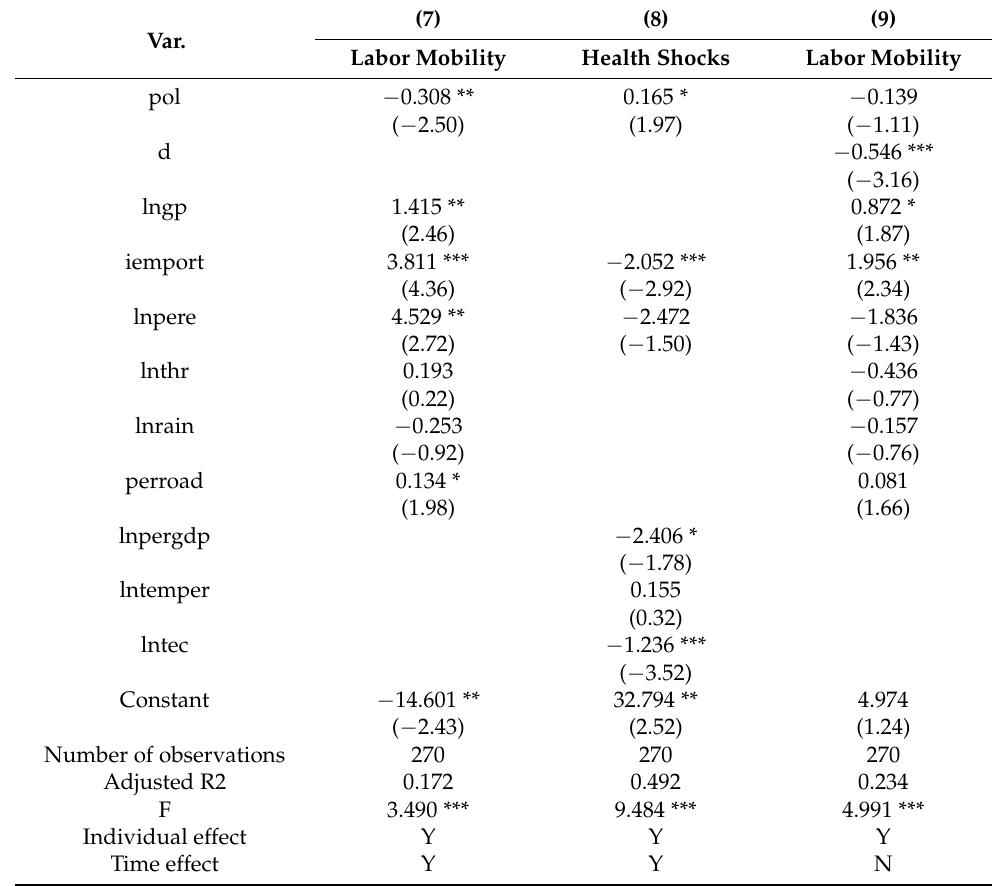
Table 3. The estimation results of the mediation